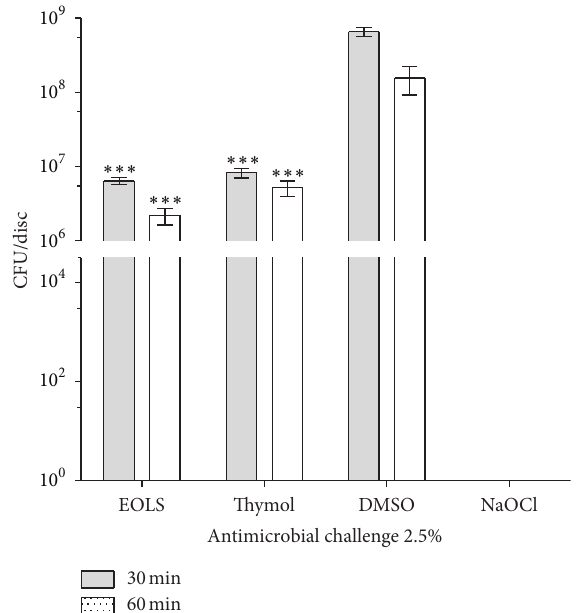
Figure 1: Susceptibility of biofilms of Enterococcus faecalis to antimicrobial challenge at 2.5% (v/v) for 30 or 60 min exposure times. EOLS, essential oil of Lippia sidoides ; DMSO, dimethyl sul- foxide(negativecontrol);andNaOCl,sodiumhypochlorite(positive control). The vertical bars indicate the standard deviation (𝑛 = 3) . ∗∗∗ 𝑃 < 0.001 compared with DMSO (two-way ANOVA followed by the Bonferroni test).